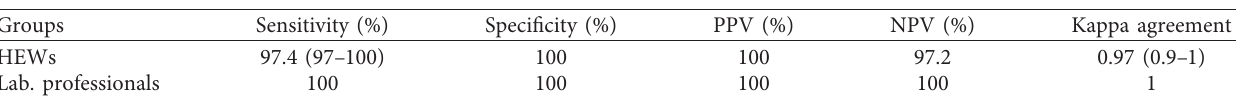
Table 2: Comparing group performance of health extension workers with laboratory professionals on HIV rapid tests ∗ .